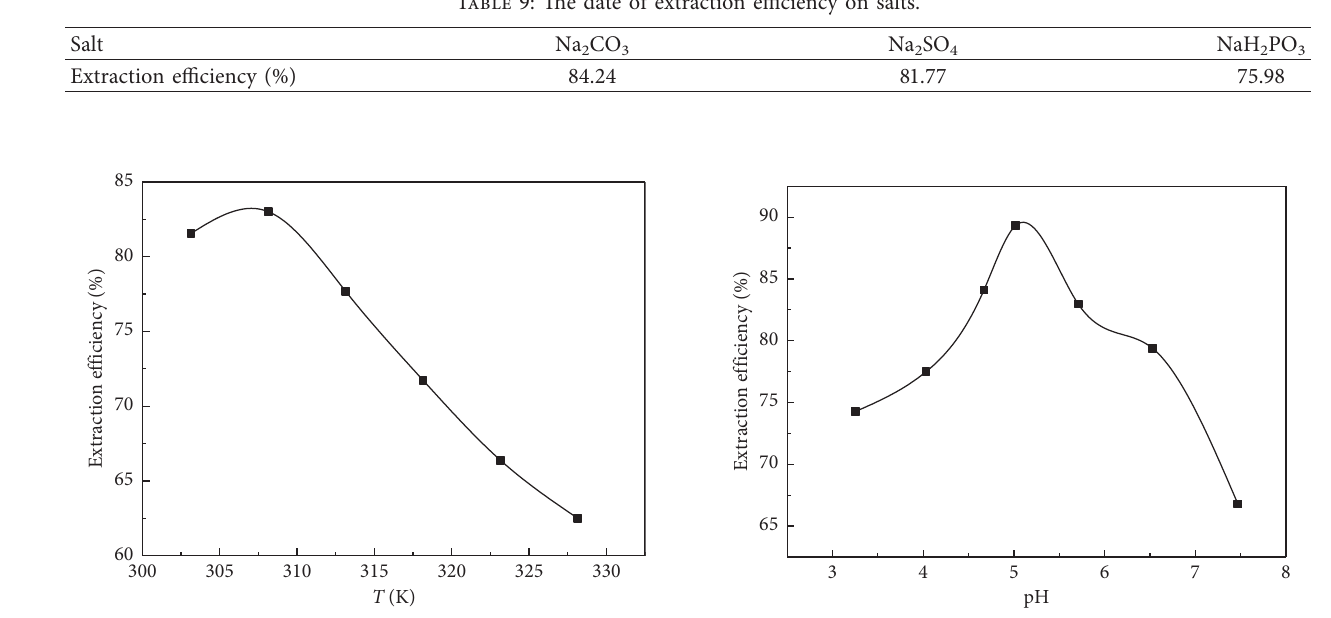
Figure 7: Effect of temperature on the extraction efficiency. Figure 8: Effect of pH on the extraction